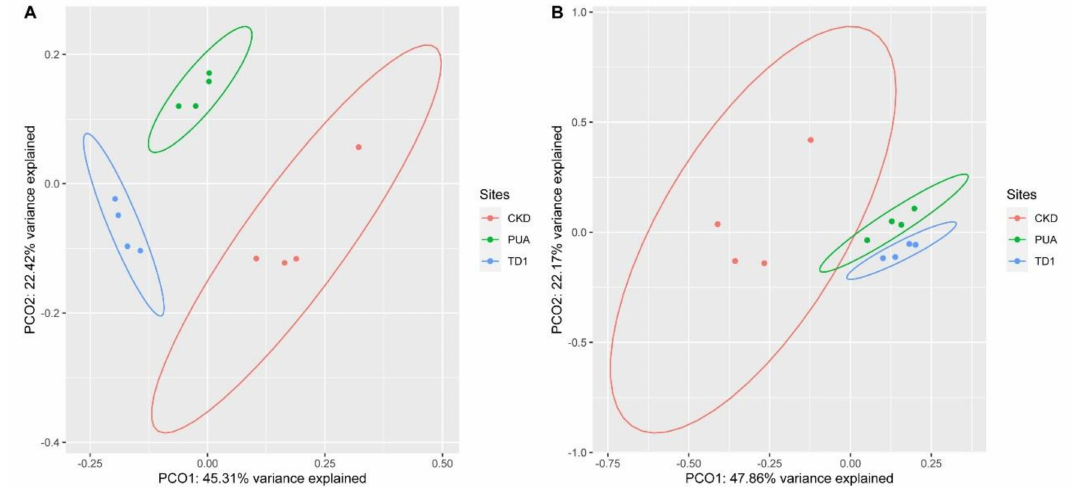
Figure 6. Principal Coordinate Analysis (PCoA) based on Bray–Curtis dissimilarity of Cladophora microbiomes collected from Nan River, Thailand. ( A ) Bacterial genera. ( B ) Eukaryotic